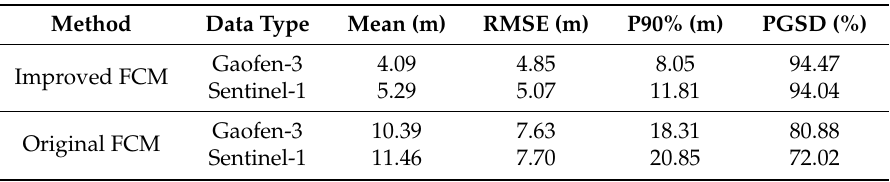
Table 4. Quantitative evaluation in the sub-region B of Bohai.